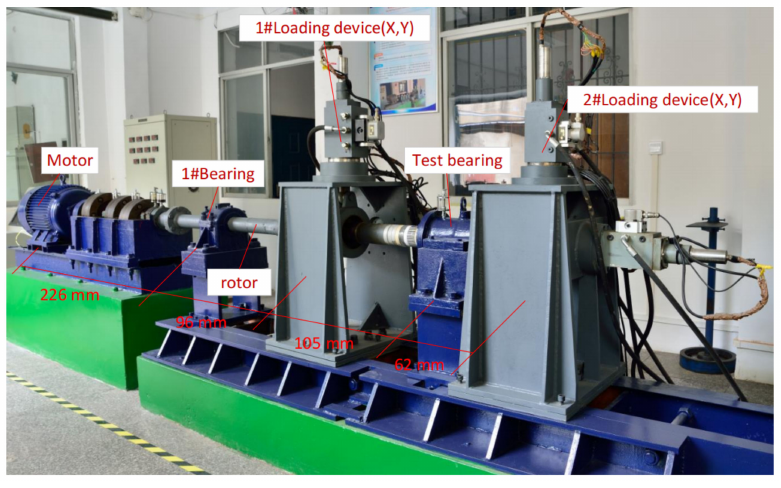
Figure 2. Test rig.